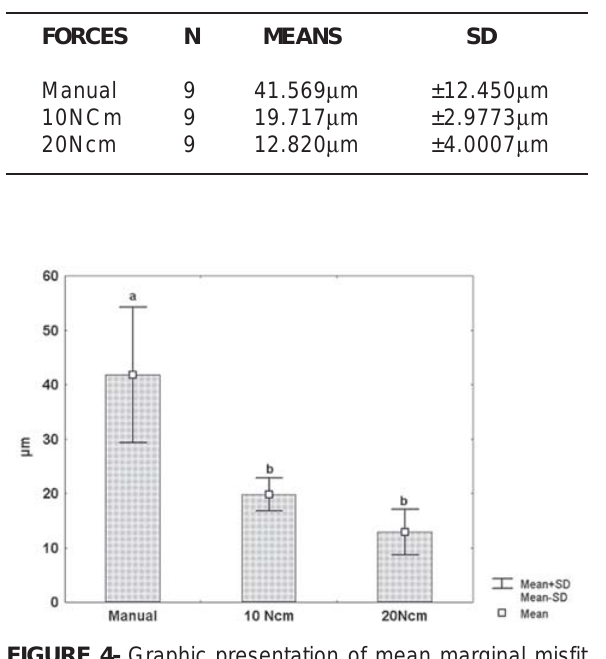
FIGURE 3- Vertical misfit gap size at the abutment- framework interface, measured under 230x microscope magnification (abutment is below)